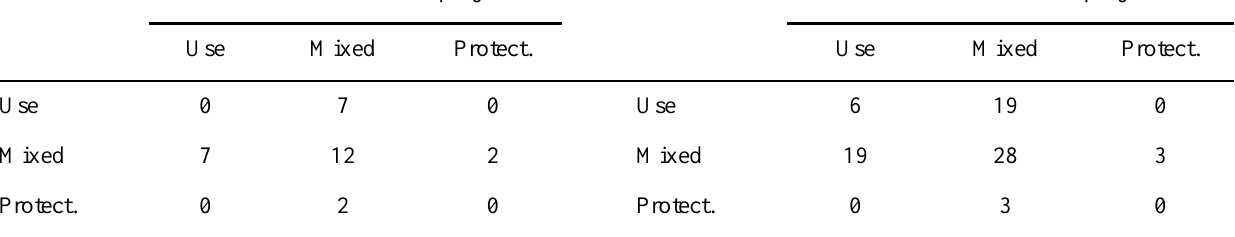
Ties established before project Ties established with project Use Mixed Protect. Use Mixed Protect. Use 0 Use 6 19 0 Mixed 7 12 2 Mixed 19 28 3 Protect. 0 2 0 Protect. 0